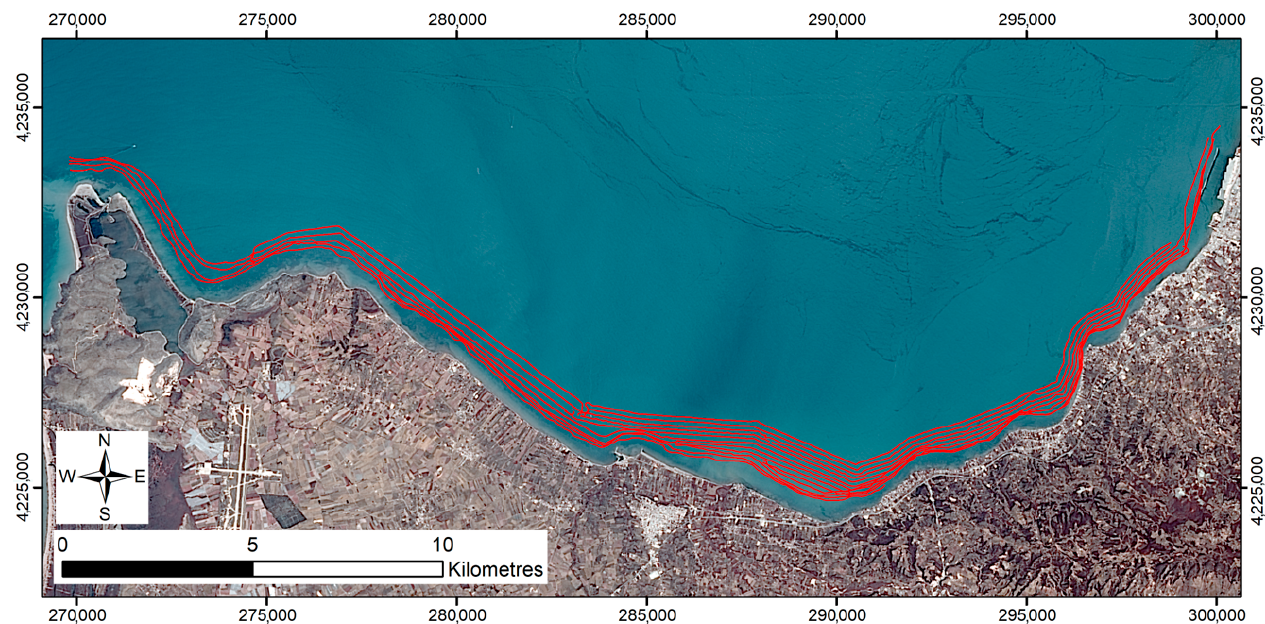
Figure 6. Map of the southern coastline of the Gulf of Patras showing the vessel tracklines.